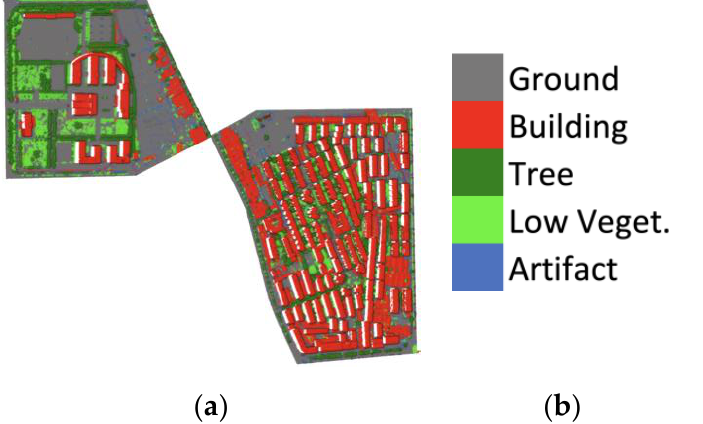
Figure 14. ( a ) Classification result of both DALES tiles with our 3DCNN, ( b ) legend. Table 9. Average and weighted F1 and IoU scores for 2DCNN and 3DCNN classifiers for the LASDU dataset. The OA is also reported. Figure 15. ( a ) 3DCNN classification results on the testing area of the LASDU dataset, ( b ) legend. Table 10. Average and weighted F1 and IoU scores for 2DCNN and 3DCNN classifiers for the Bordeaux dataset. The OA is also reported.